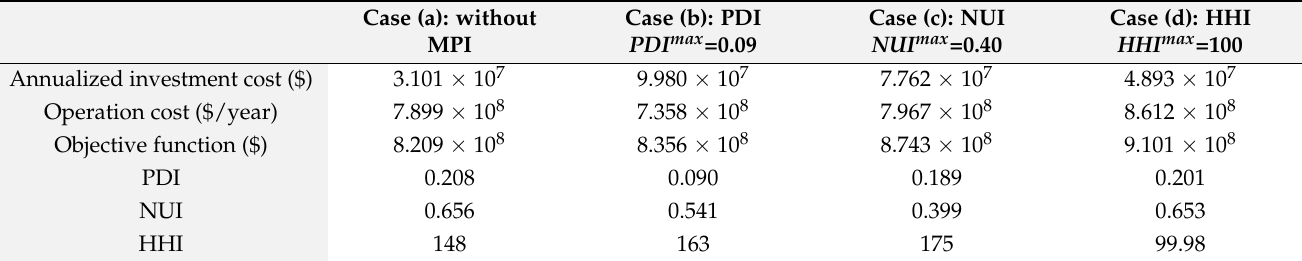
Table 1. Optimal solutions for four different cases considering different market power